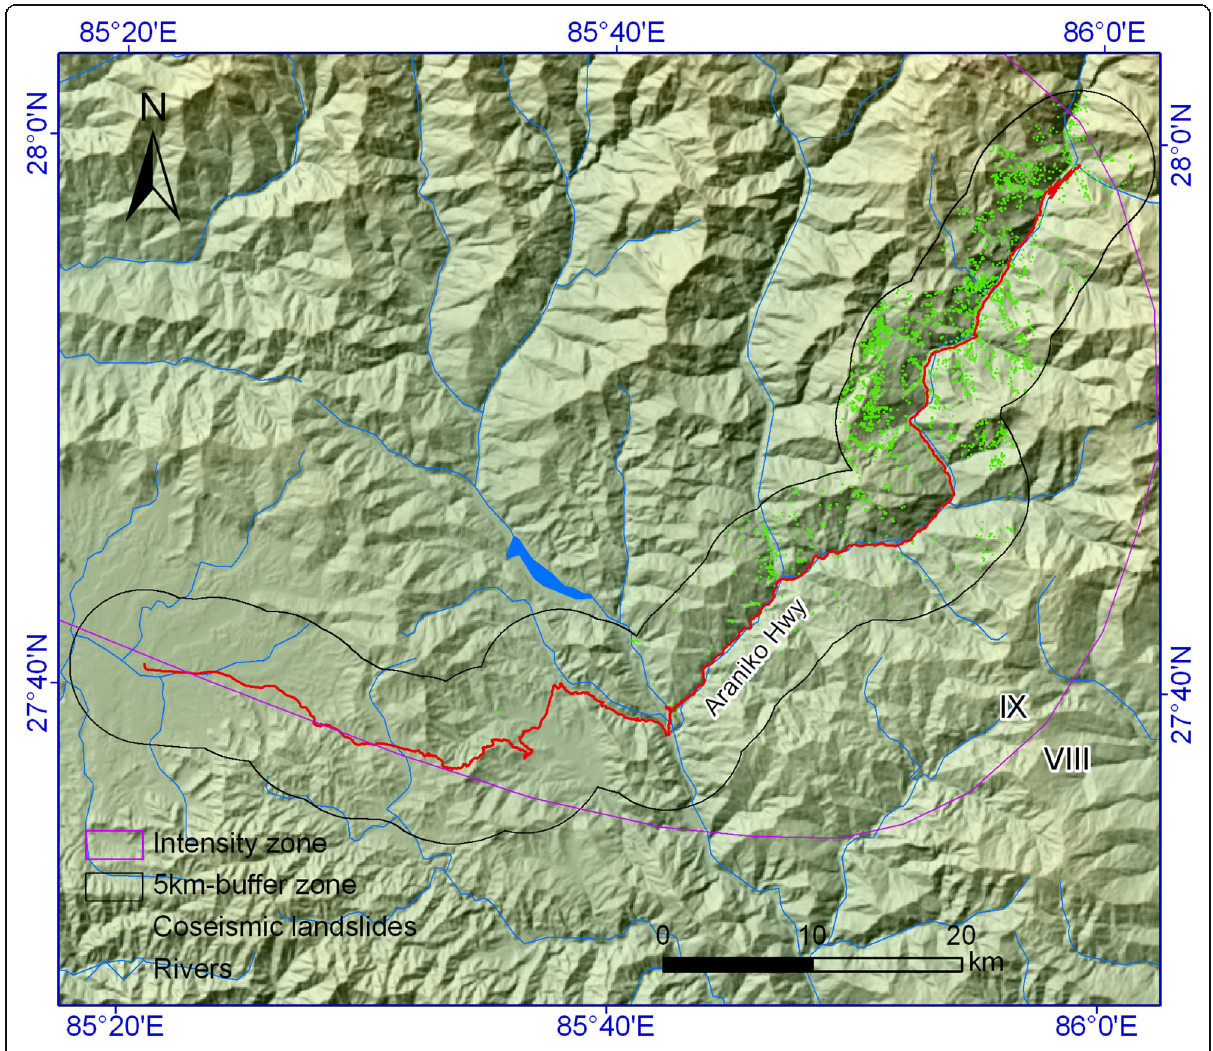
Fig. 9 Distribution map of coseismic landslides in the 5-km buffer area on either side the Araniko